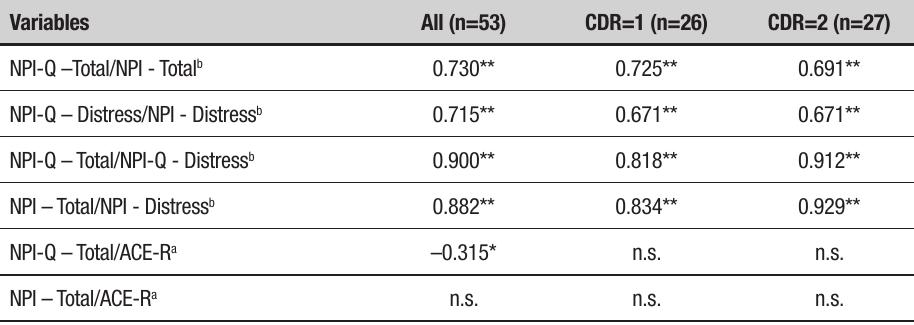
Table 2. Inter-scale correlations among the NPI, NPI-Q, and